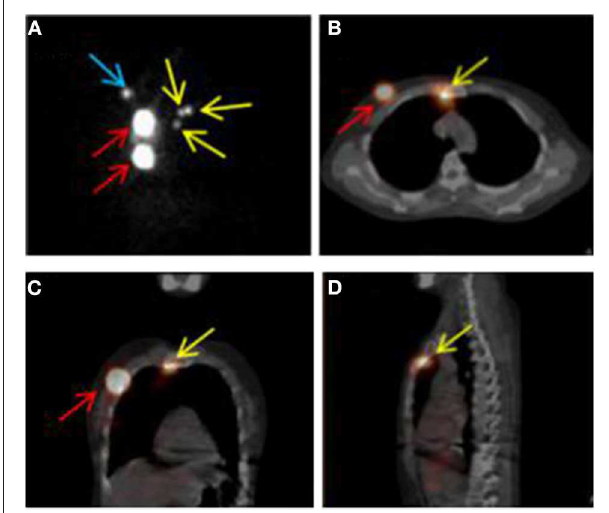
FIGURE 1 | SPECT/CT combination imaging and positive sentinel lymph nodes. (A) SPECT image in anteroposterior position. (B–D) SPECT/CT fusion images. Red, yellow, and blue arrows indicate injection points, positive internal mammary sentinel lymph nodes, and axillary sentinel lymph node, respectively.